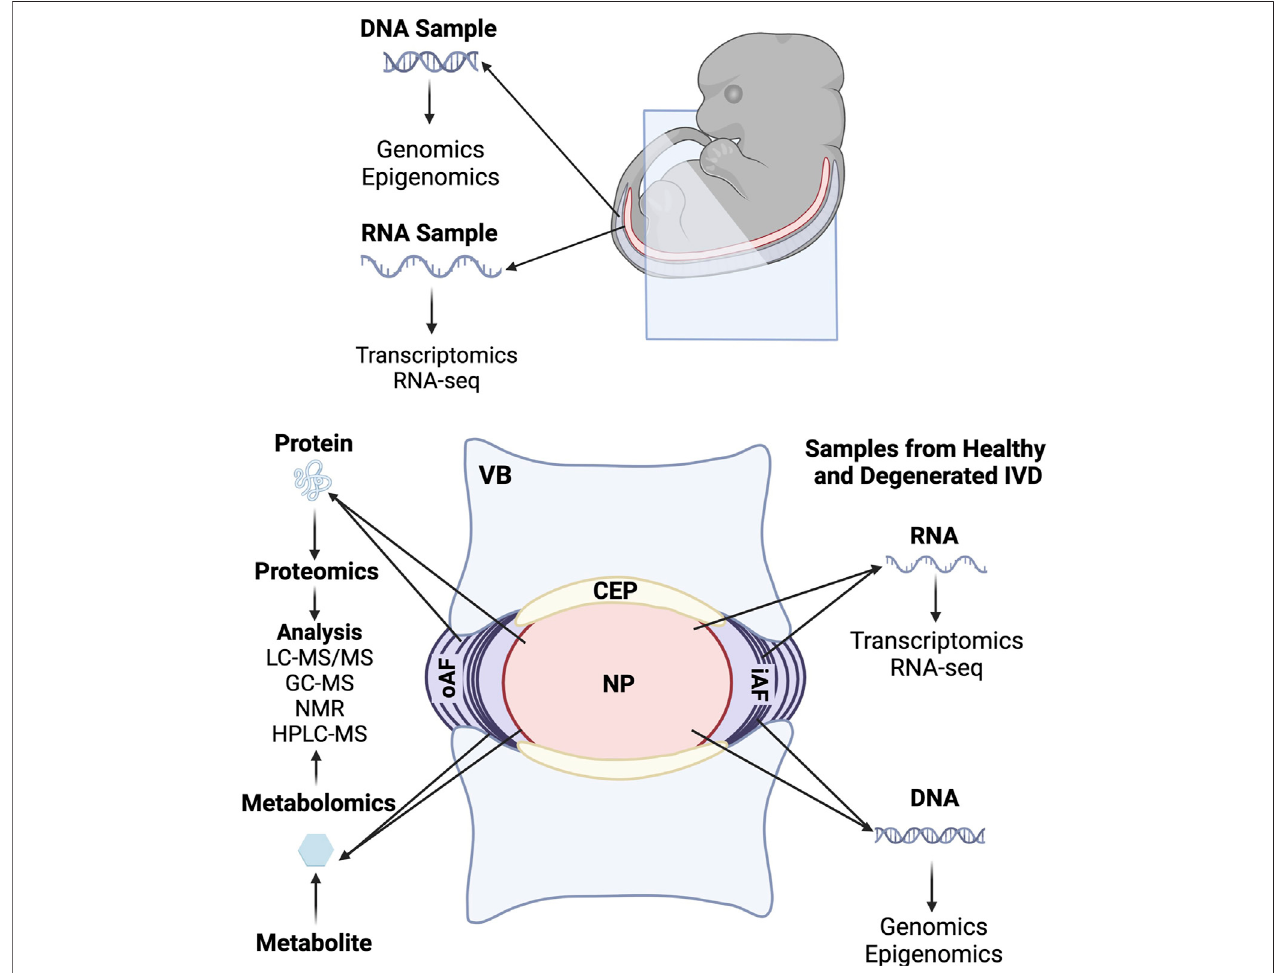
FIGURE 3 | Summary of omics investigations carried out during embryonic development and in the fully formed intervertebral disc.